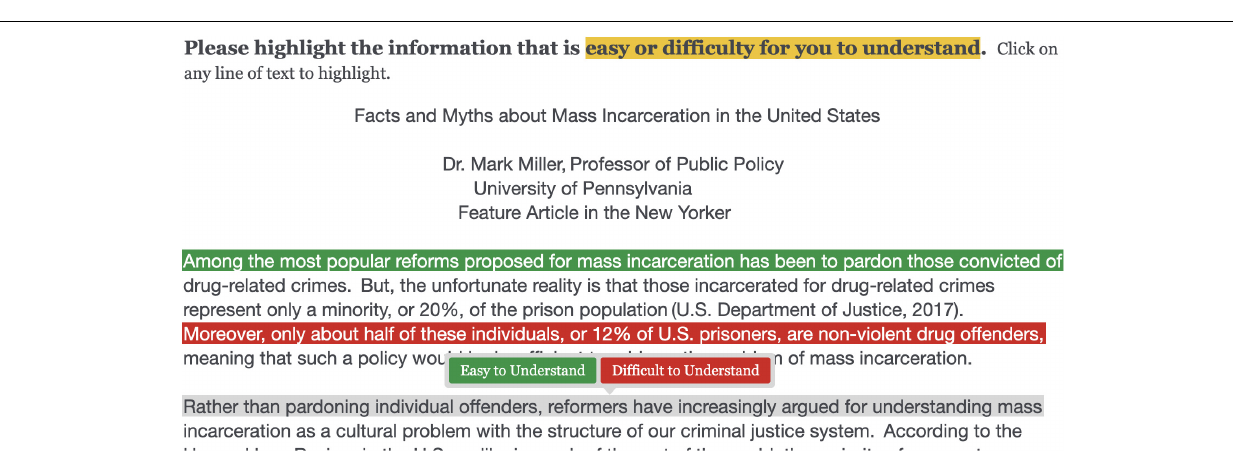
FIGURE 3 | Screenshot of highlighter tool for the metacognitive strategy